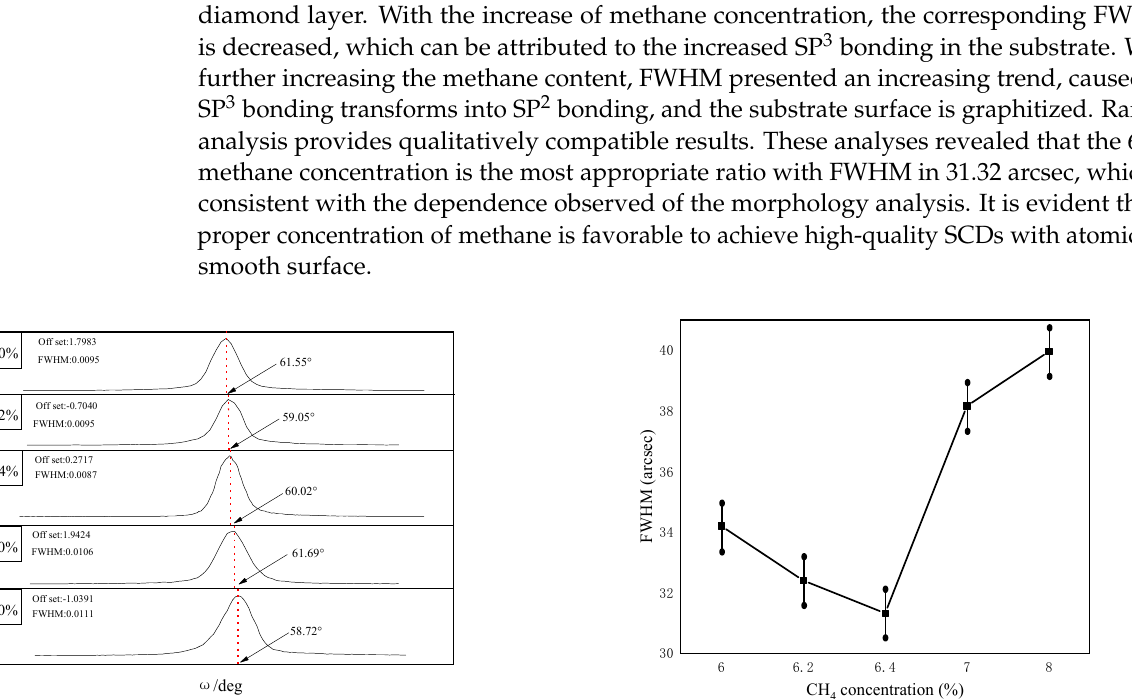
Figure 4. Raman spectra of substrates grown on different concentrations of CH 4 . Figure 5a shows the XRD rocking curve patterns taken from the growth surface of the diamonds. The fitted FWHM of the XRD peak is plotted as a function of CH 4 concentration (Figure 5b) as well. Variation of the rocking curve peak position is due to the original HPHT substrate and mechanical bending of the crystal [28,29]. The X-ray intensity of a single pixel is extracted from the image series scanned by a given rocking curve, and the peak position and width of the pixel are extracted by Gaussian fitting. The relatively low FWHM of all samples are narrower than 40 arcsec, comparable with the electronic grade SCDs commercially purchased from EDP Ltd., illustrates a high-quality diamond layer. With the increase of methane concentration, the corresponding FWHM is decreased, which can be attributed to the increased SP 3 bonding in the substrate. With further increasing the methane content, FWHM presented an increasing trend, caused by